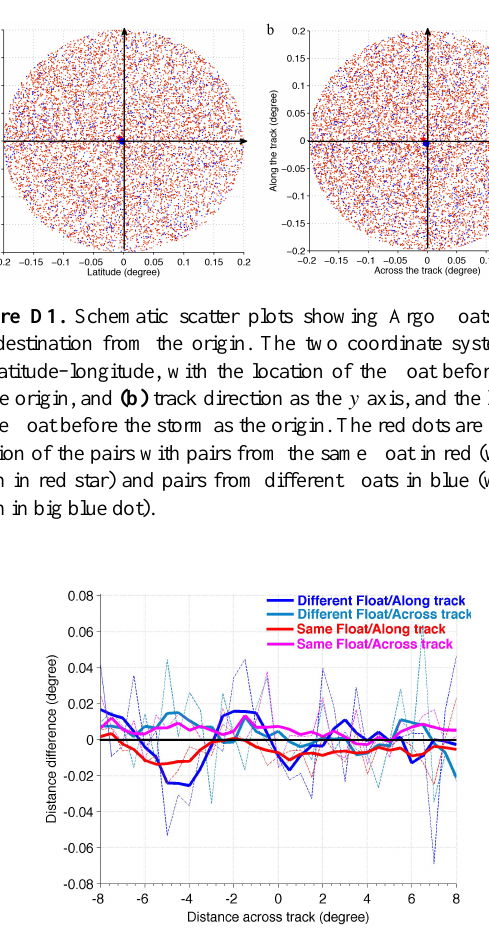
Figure D2. Horizontal distance difference between the two profiles in a TC-affected pair along and across the track as a function of the distance from the float location to the track center (dashed curves). Here the distance is calculated in track coordinates; i.e., a positive distance across the track represents the inertial-resonant side (right side in the Northern Hemisphere and left side in the Southern Hemi- sphere). The horizontal distances by using pairs where the two pro- files are from different floats are shown in dark blue (along track) and light blue (across track), while drifting distances based on the remaining pairs are shown in purple (across track) and red (along track). The values are further smoothed using a five-point (2.5 ◦ ) moving filter (solid